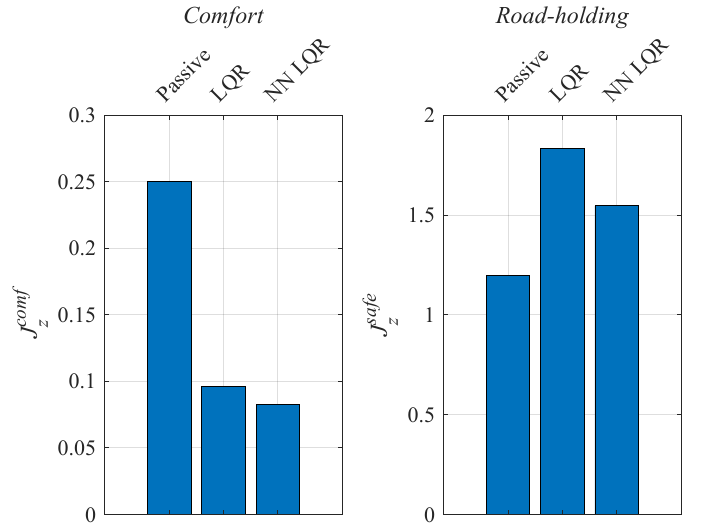
Figure 6. Comparison of performance indexes of the analysed suspension